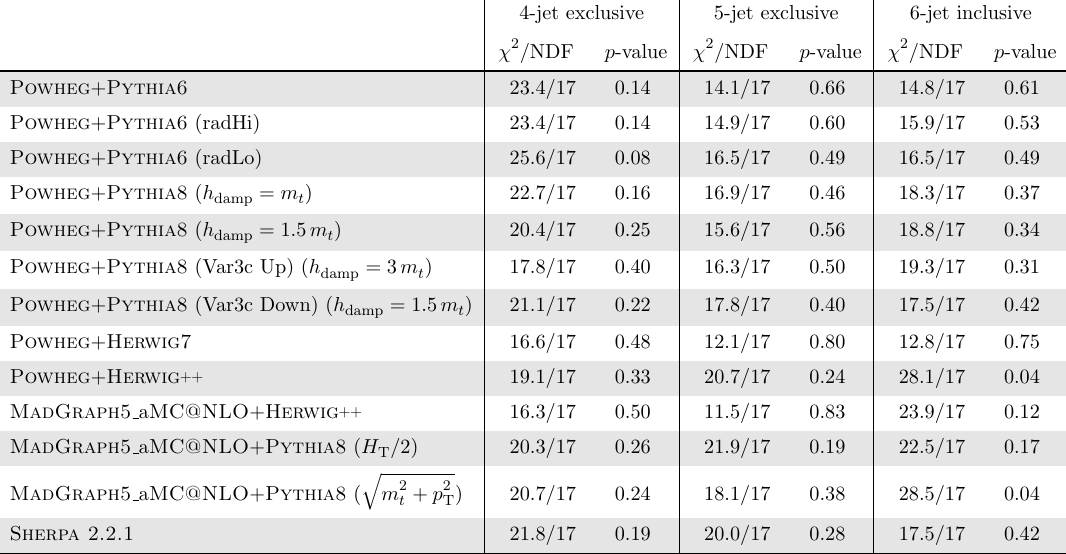
Table 4 . Comparison of the measured (cid:12)ducial phase space normalised di(cid:11)erential cross sections as a function of p t; had and the predictions from several MC generators in di(cid:11)erent n -jet con(cid:12)gurations. T For each prediction a (cid:31) 2 and a p -value are calculated using the covariance matrix of the measured spectrum. The number of degrees of freedom (NDF) is equal to the number of bins in the distribution minus one.